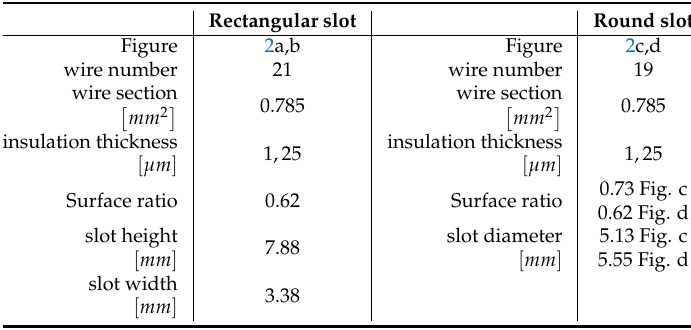
Table A1. Type and dimension of slot application. Rectangular slot Round slot Figure 2a,b Figure 2c,d wire number wire number 19 wire section